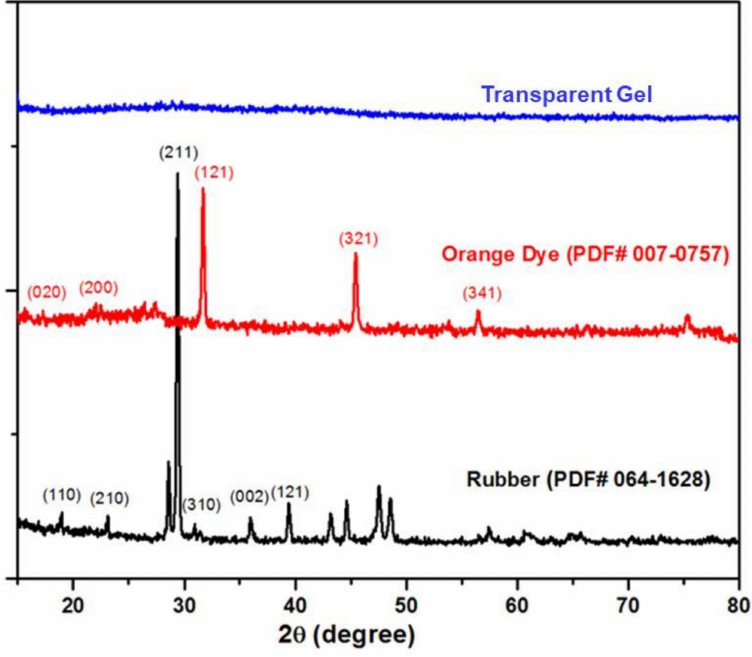
Figure 1. XRD scans of the OD, transparent gel, and rubber